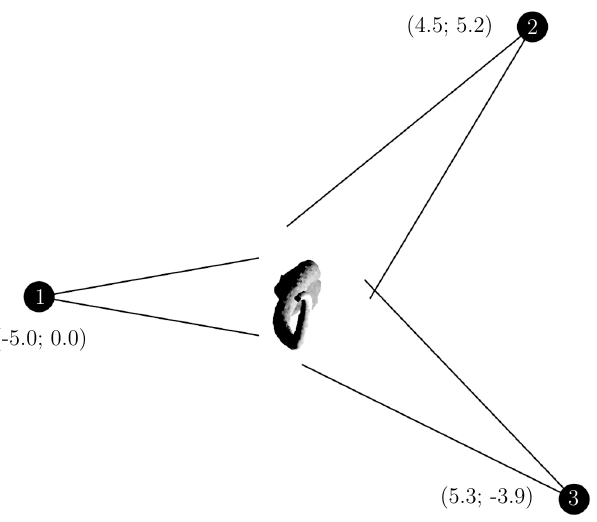
Figure 13. Simulated scanner setup. Stem Model 7 is visualized as the object. ( x ; y ) -coordinates given for the positions. At each position, the scanner is at 1.5 m above the ground.